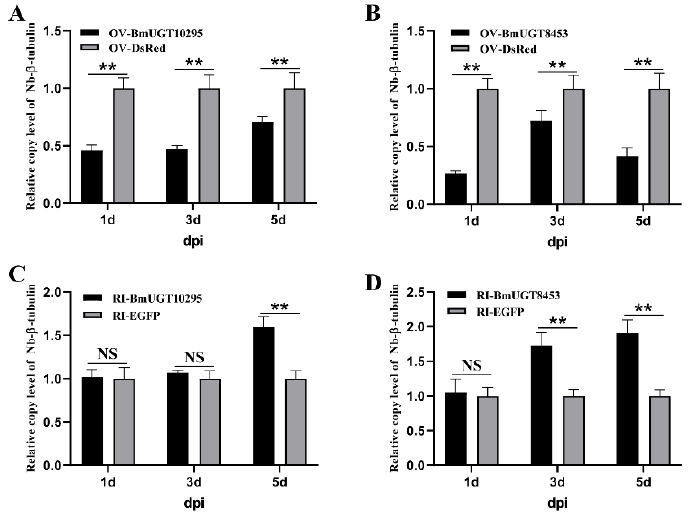
Figure 6. BmUGT10295 and BmUGT8453 inhibited Nosema bombycis infection. The N. bombycis β -tubulin relative copy levels in over-expressed BmUGT10295 ( A ) and BmUGT8453 ( B ) cells were lower than that in over-expressed DsRed cells. The N. bombycis β -tubulin relative copy levels in RNAi BmUGT10295 ( C ) and BmUGT8453 ( D ) cells were higher than that in RNAi EGFP cells. The relative copy levels were estimated according to the 2 −ΔΔCt method. sw22934 was used as an internal reference. Over-expressed DsRed and RNAi EGFP were used for calibration (value 1). Bars represent the mean of three individual measurements ± SD. Statistical significance was determined by an unpaired t-test, and statistically significant differences are represented with asterisks (** p < 0.01).